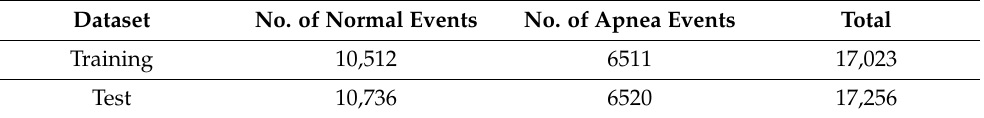
Table 2. Number of normal and apnea events for the subject-dependent training and test datasets. Dataset